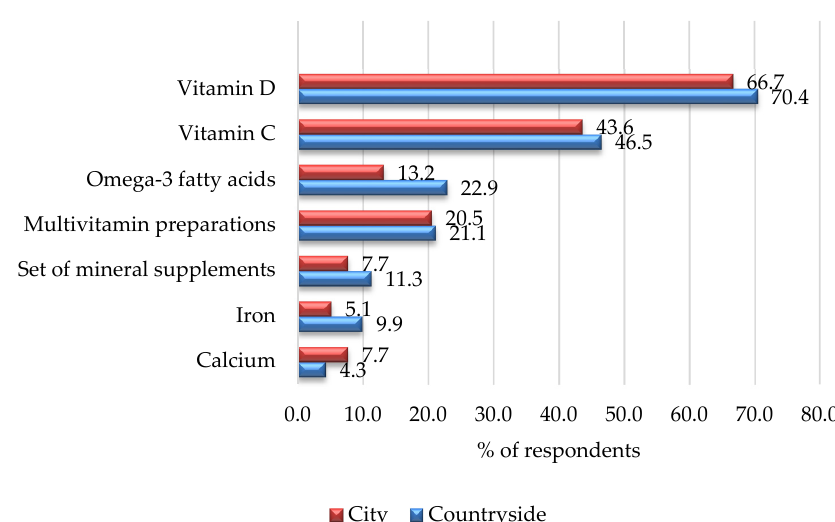
Figure 1. Percentage of children taking supplements by place of residence.